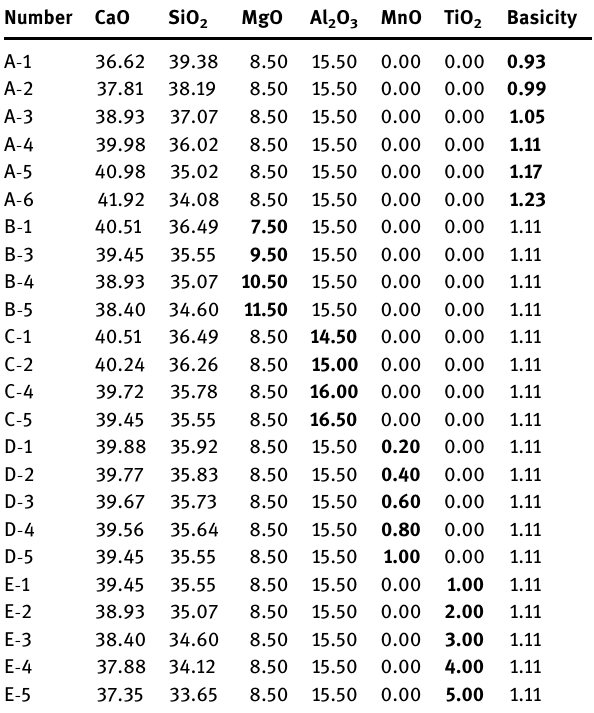
Table 1: The mass fraction of slag